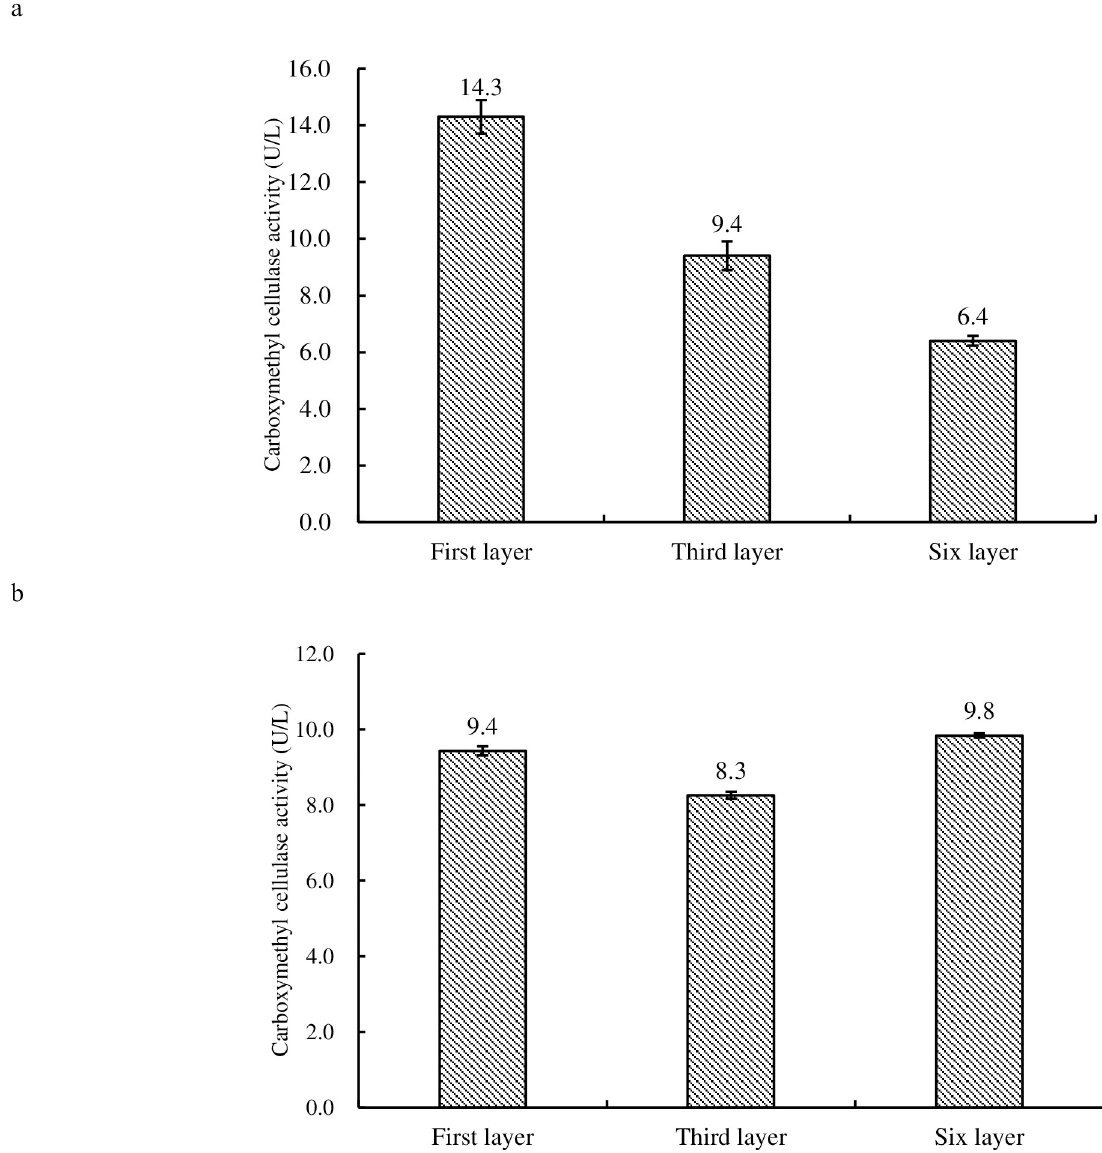
Fig 6. Comparison of CMCase activity in budding fruiting bodies (6a) and mature fruiting bodies (6b) of 1 st , 3 rd and 6 th tier of H . marmoreus